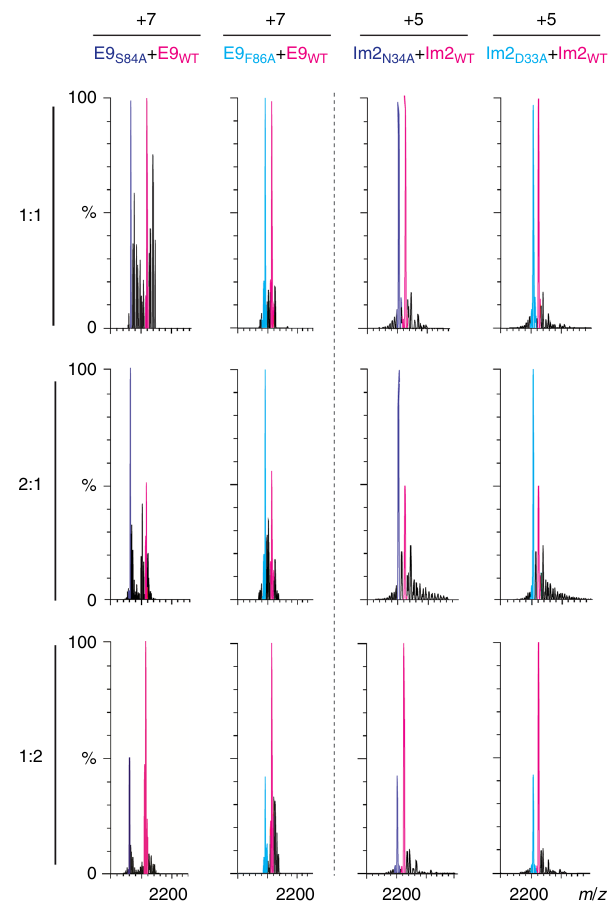
Fig. 2 Peak areas re fl ect solution concentrations of proteins. Comparison of the ratios of peak areas of the mutant and wild-type proteins with their relative respective solution concentrations of 1:1, 2:1, and 1:2 shows that they are in excellent agreement. Expansions of charge states +7 and +5 are shown for the E9 and Im2 variants, respectively